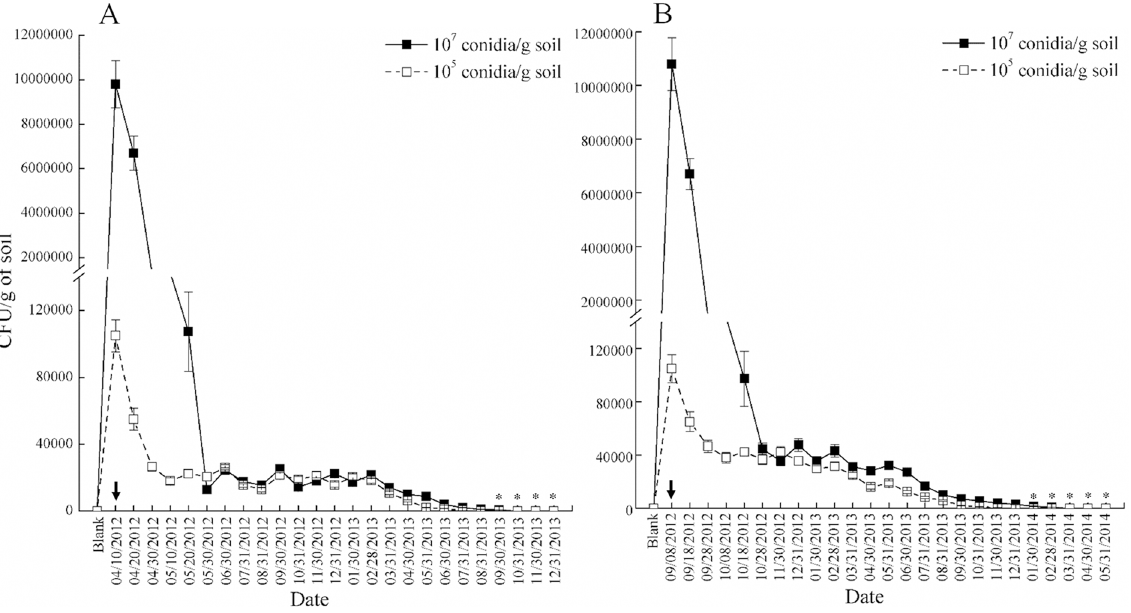
Fig 3. Fungus densities in the soil inoculated with L . lecanii conidia. Asterisk indicated that L . lecanii had not been detected from treated soils using the selective medium (oatmeal CTAB 0.5